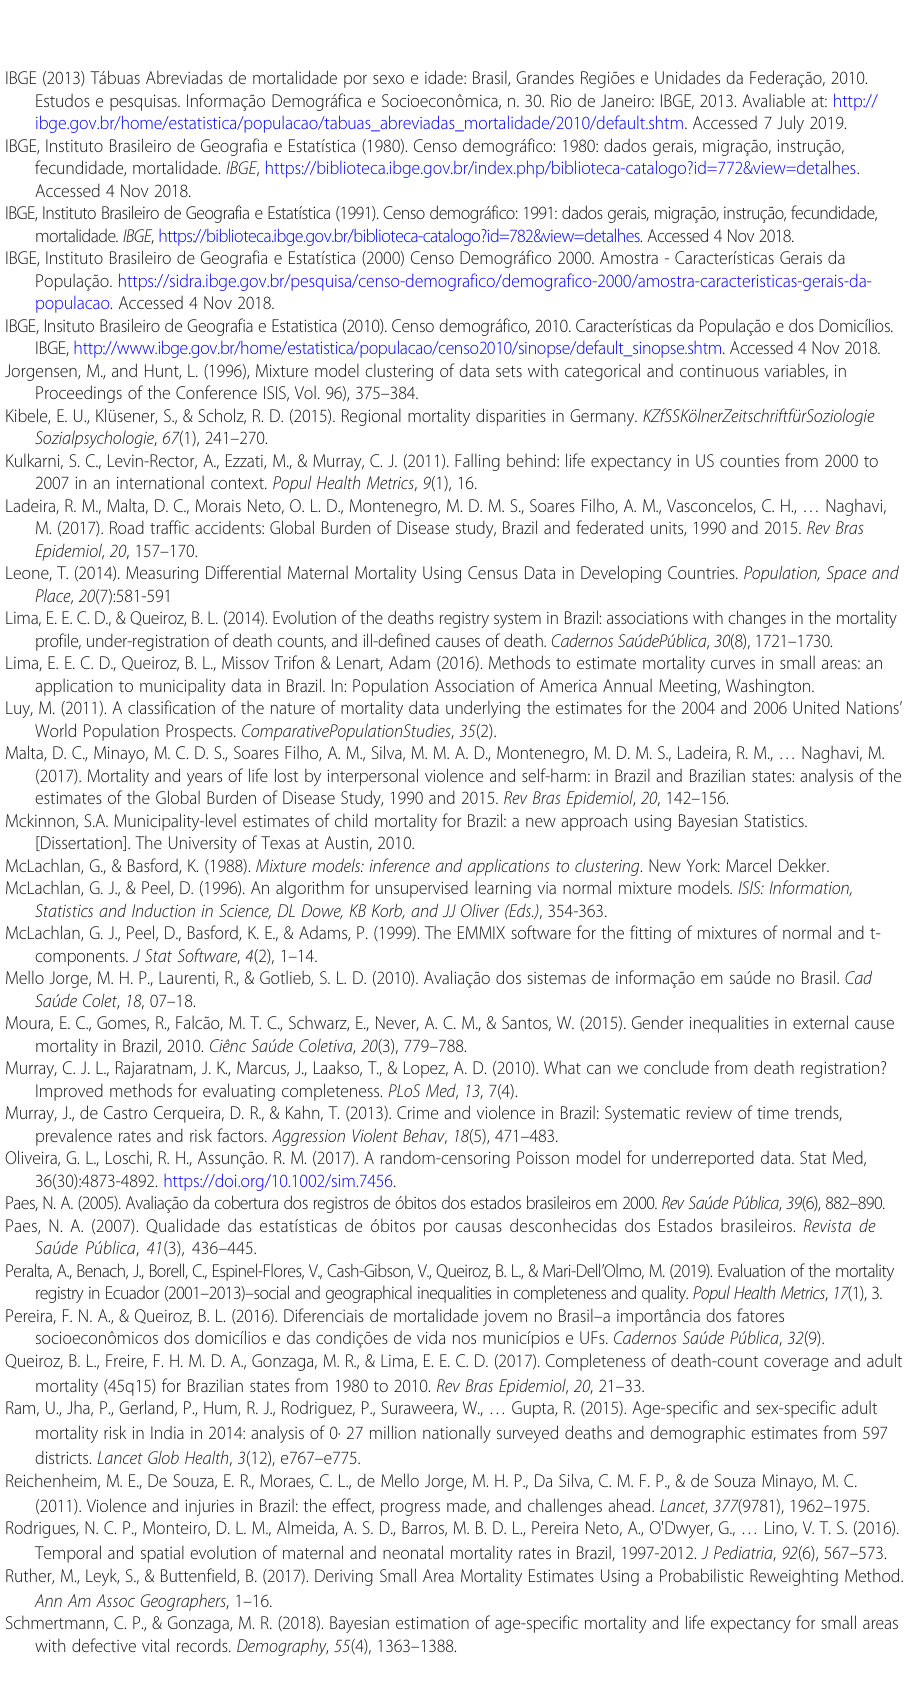
IBGE (2013) Tábuas Abreviadas de mortalidade por sexo e idade: Brasil, Grandes Regiões e Unidades da Federação, 2010. Estudos e pesquisas. Informação Demográfica e Socioeconômica, n. 30. Rio de Janeiro: IBGE, 2013. Avaliable at: http:// ibge.gov.br/home/estatistica/populacao/tabuas_abreviadas_mortalidade/2010/default.shtm. Accessed 7 July 2019. IBGE, Instituto Brasileiro de Geografia e Estatística (1980). Censo demográfico: 1980: dados gerais, migração, instrução, fecundidade, mortalidade. IBGE , https://biblioteca.ibge.gov.br/index.php/biblioteca-catalogo?id=772&view=detalhes. Accessed 4 Nov